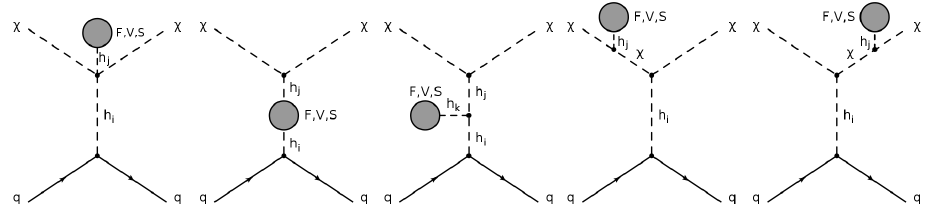
Figure 4 . One-loop diagrams with loops containing SM particles, A or H ± with F ∈ { u, c, s, c, b, t } , V ∈ { Z, W } and S ∈ { G 0 , G ± , A, H ± }